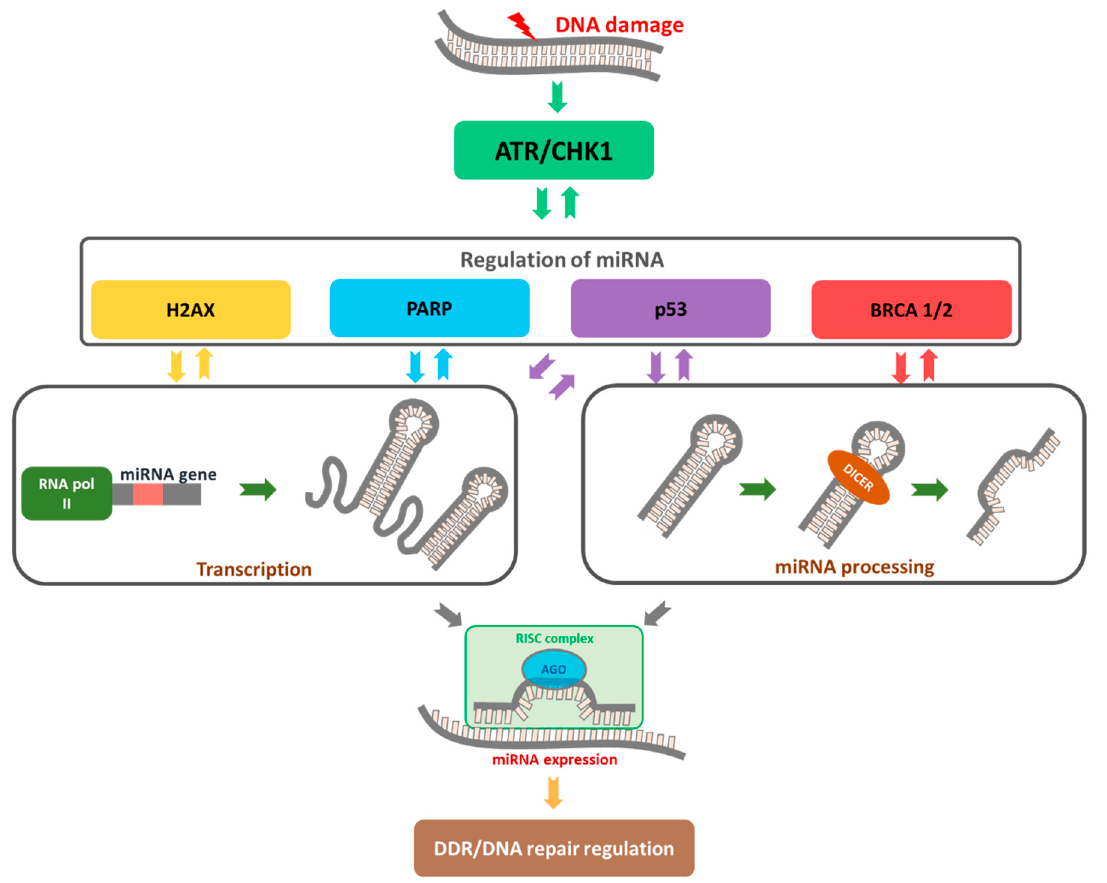
Figure 2. The role of miRNAs as a regulator of DDR. DNA damage triggers the activation of the ATR/CHK1 pathway, which is responsible for substrates phosphorylation (i.e., H2AX, p53, and BRCA 1/2) to repair DNA damage. Single-strand DNA damage is identified and repaired by poly (ADP-ribose) polymerase (PARP) pathway activation, predominantly through base excision repair (BER). With continuous PARP inhibition, ssDNA breaks are converted to dsDNA breaks during DNA replication in which replication forks stall at the point of DNA damage. Over-expressed or down-regulated miRNAs may affect DDR by changing the expression of repair genes.